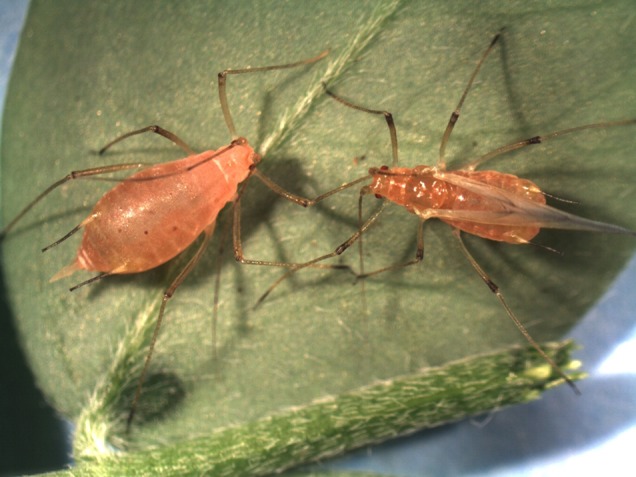
Wing polyphenism in aphids. Winged (right) and wingless (left) forms of female aphids, Acyrthosiphon pisum (Reproduced with permission from Simpson et al., 2011).